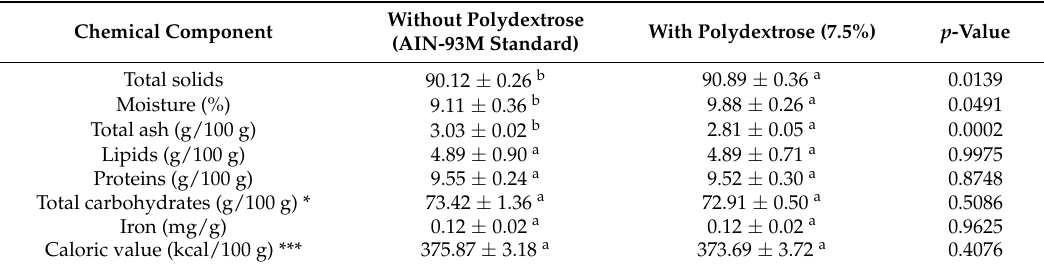
Table 2. Composition, iron and energy value of experimental diets formulated according to AIN-93M. Chemical